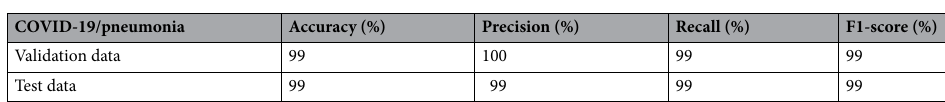
Table 2. Classification performance obtained by enhanced VGG16 on X-ray images: COVID-19/pneumonia.